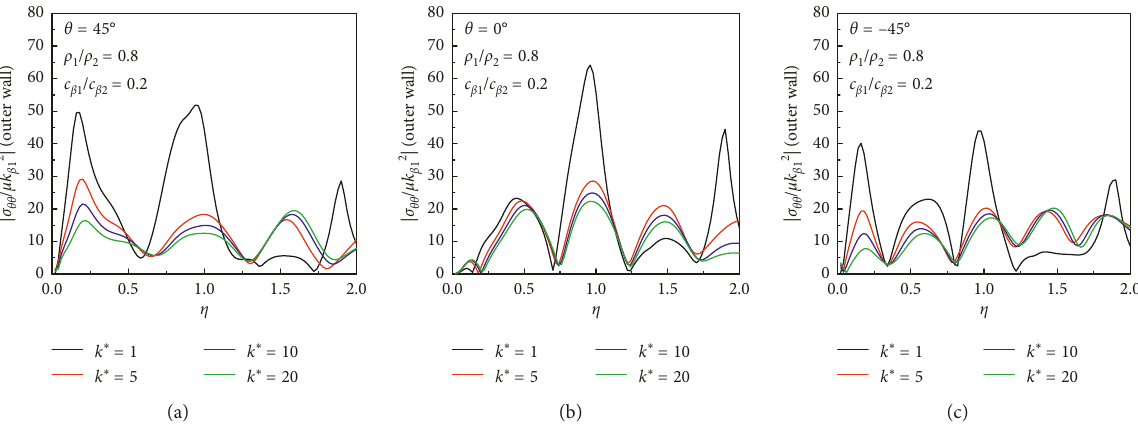
45 ° ; (b) θ 0 ° ; (cid:29) (cid:29)